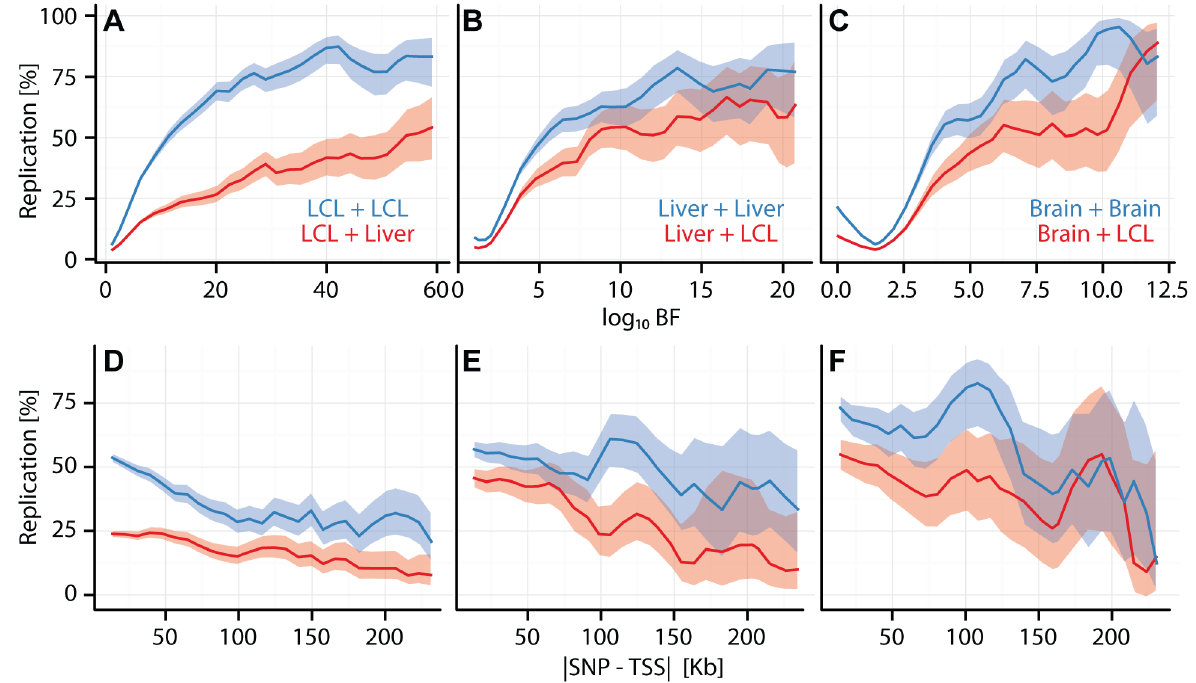
Figure 2. Cell type specific eQTL replication frequencies. (A, B, C) eQTL replication frequency (y-axis) as a function of discovery significance (x- axis: log 10 BF ). SNPs were grouped into 30 equally spaced bins by BF. (D, E, F) eQTL replication frequency (y-axis; thresholded at 5% FDR ) as a function of SNP position ( D SNP { TSS D ) (x-axis). Cis-eQTL SNPs within 250 kb of the TSS were grouped into 30 equally spaced bins. (A, D) Replication frequencies for CAP_LCL eQTLs in Stranger_LCLs (blue) and Merck_liver (red). (B, E) Replication frequencies for UChicago_liver eQTLs in Merck_liver (blue) and Stranger_LCL (red). (C, F) Replication frequencies for Myers_brain eQTLs in Harvard_cerebellum (blue) and Stranger_LCL (red). In all panels, bold lines depict percentage of SNP-gene pairs with log 10 BF § 1 per bin, and ribbons depict 95% confidence interval.